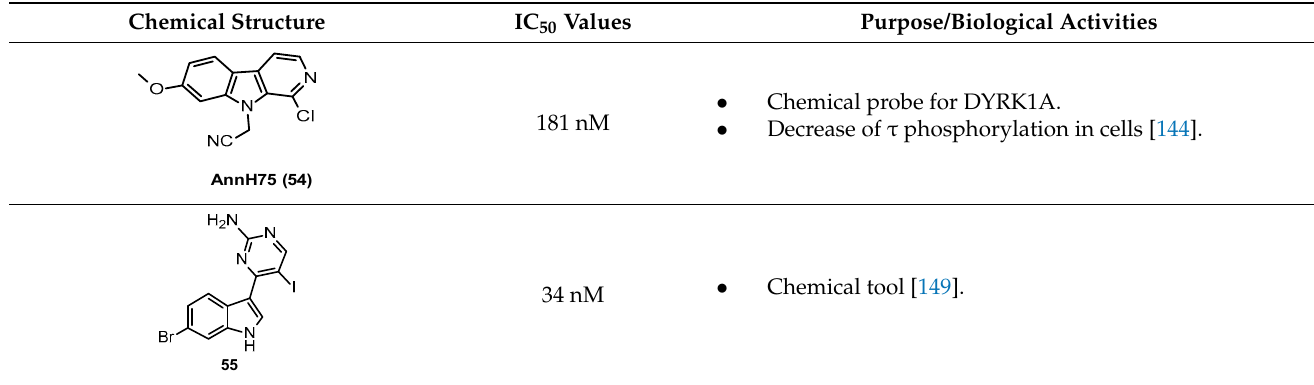
Table 3. ATP-competitive DYRK1A inhibitors and their